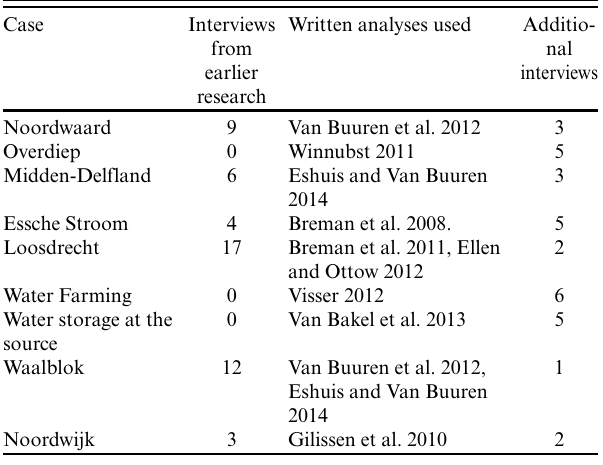
Table 2 . List of sources